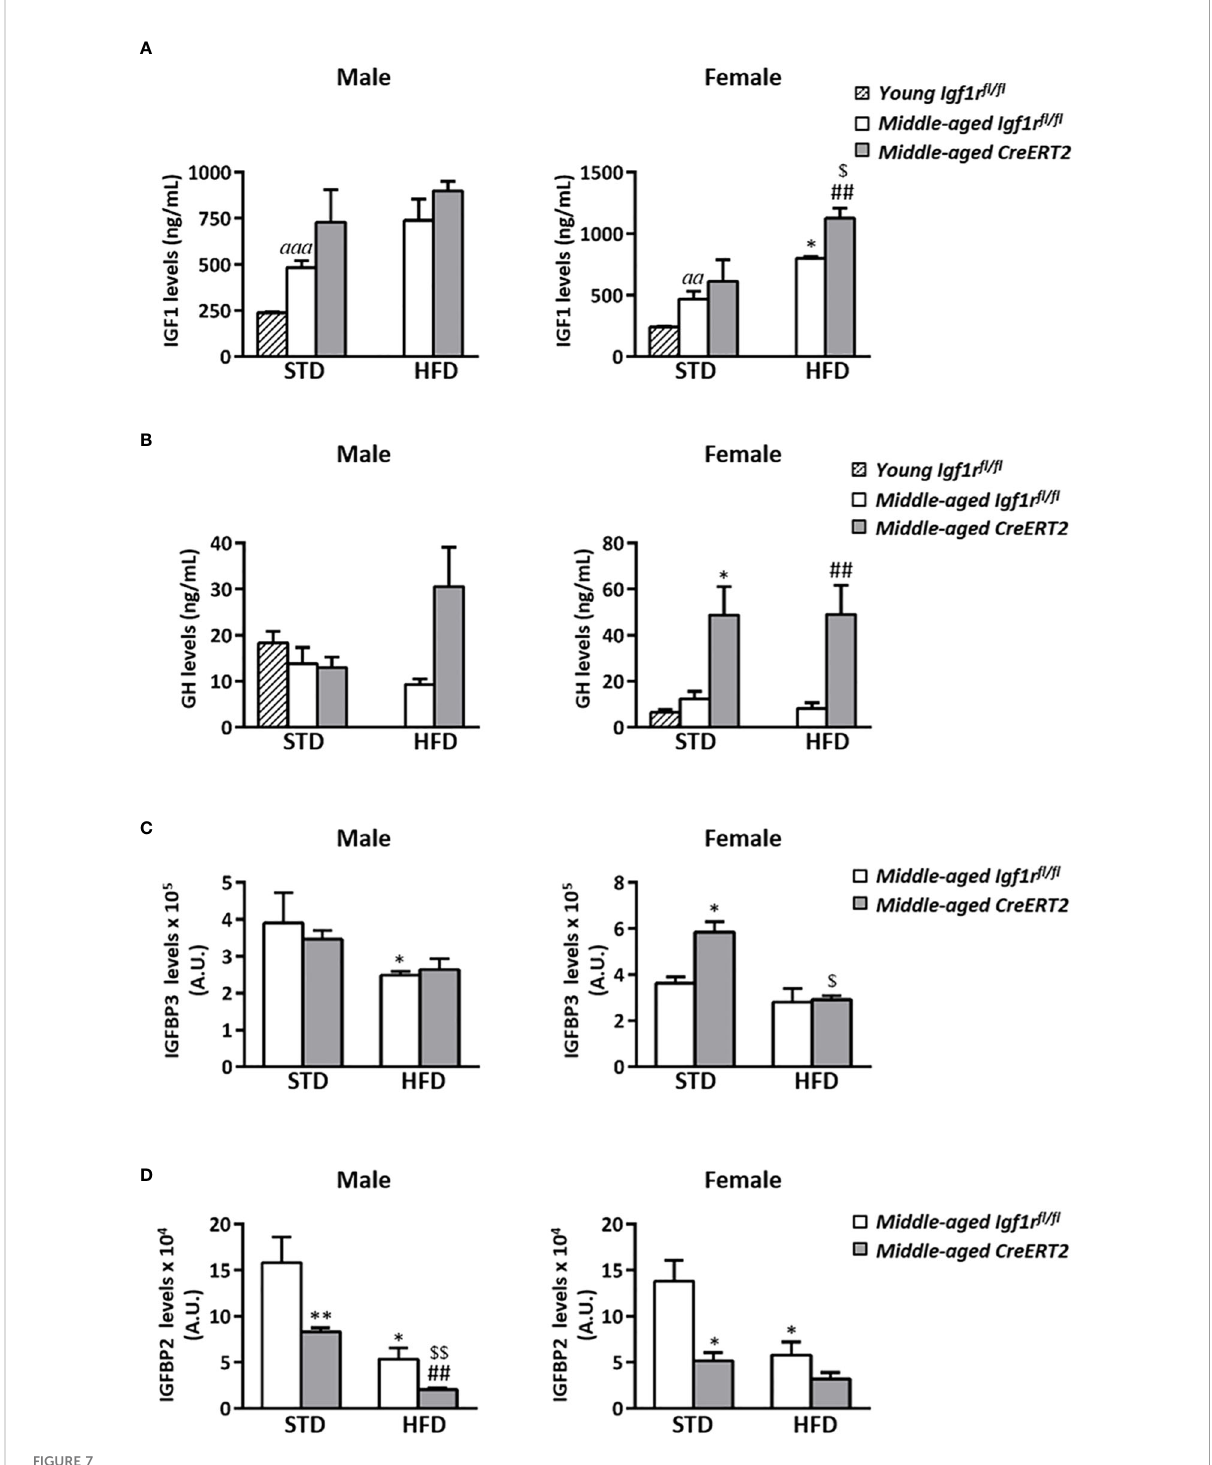
FIGURE 7 Impact of IGF1R de fi ciency on IGF1, GH, IGFBP3 and IGFBP2 serum levels of middle-aged mice. Quanti fi cation of circulating levels of IGF1 (A) GH (B) IGBP3 (C) and IGFBP2 (D) in CreERT2 male and female middle-aged mice on STD and HFD compared to Igf1r fl / fl counterparts and to young control ( Igf1r fl / fl ) male and females on STD. Data are expressed as mean ± SEM of at least 2 animals per group (n= 2-11 mice per group). aa p < 0.01 and aaa p < 0.001 vs . young Igf1r fl / fl mice. *p < 0.05, **p < 0.01 vs . middle-aged Igf1r fl / fl STD animals; ## p < 0.01 vs. middle-aged Igf1r fl / fl HFD mice, and $ p < 0.05, $$ p < 0.01 vs. middle-aged CreERT2 STD